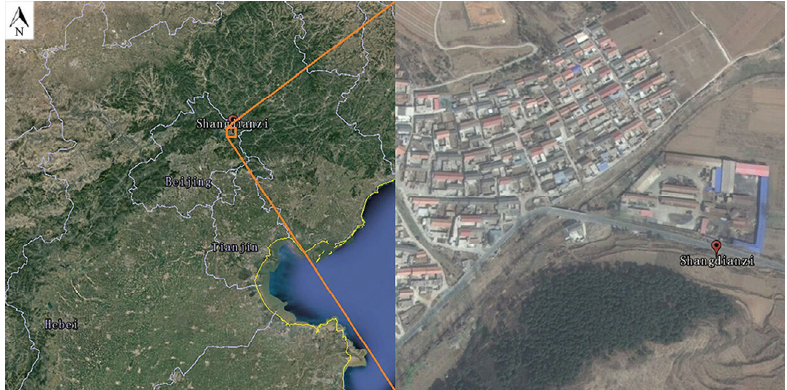
Figure 1. Location of Shangdianzi (SDZ) site.